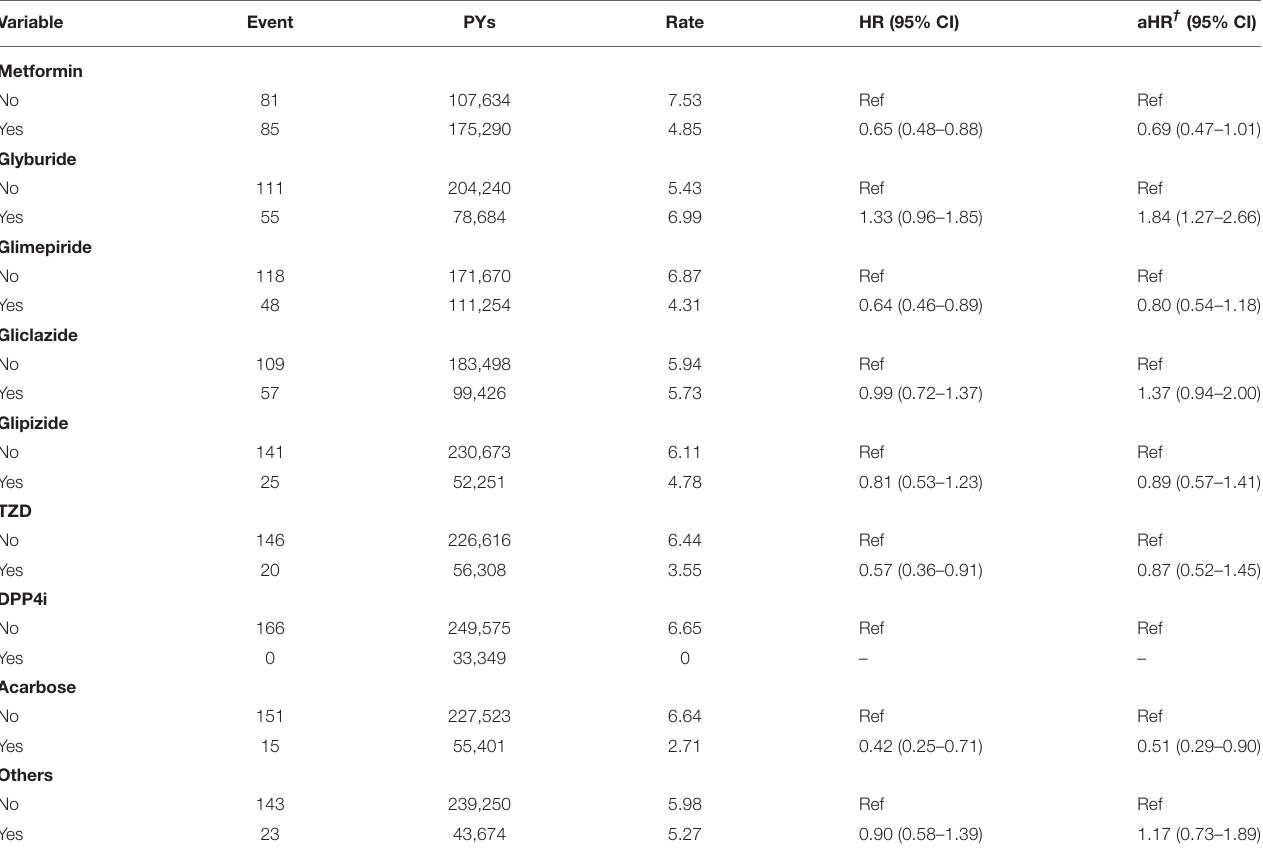
TABLE 3 | HRs and adjusted HRs for PLA in the T2DM cohort according to DM medications.